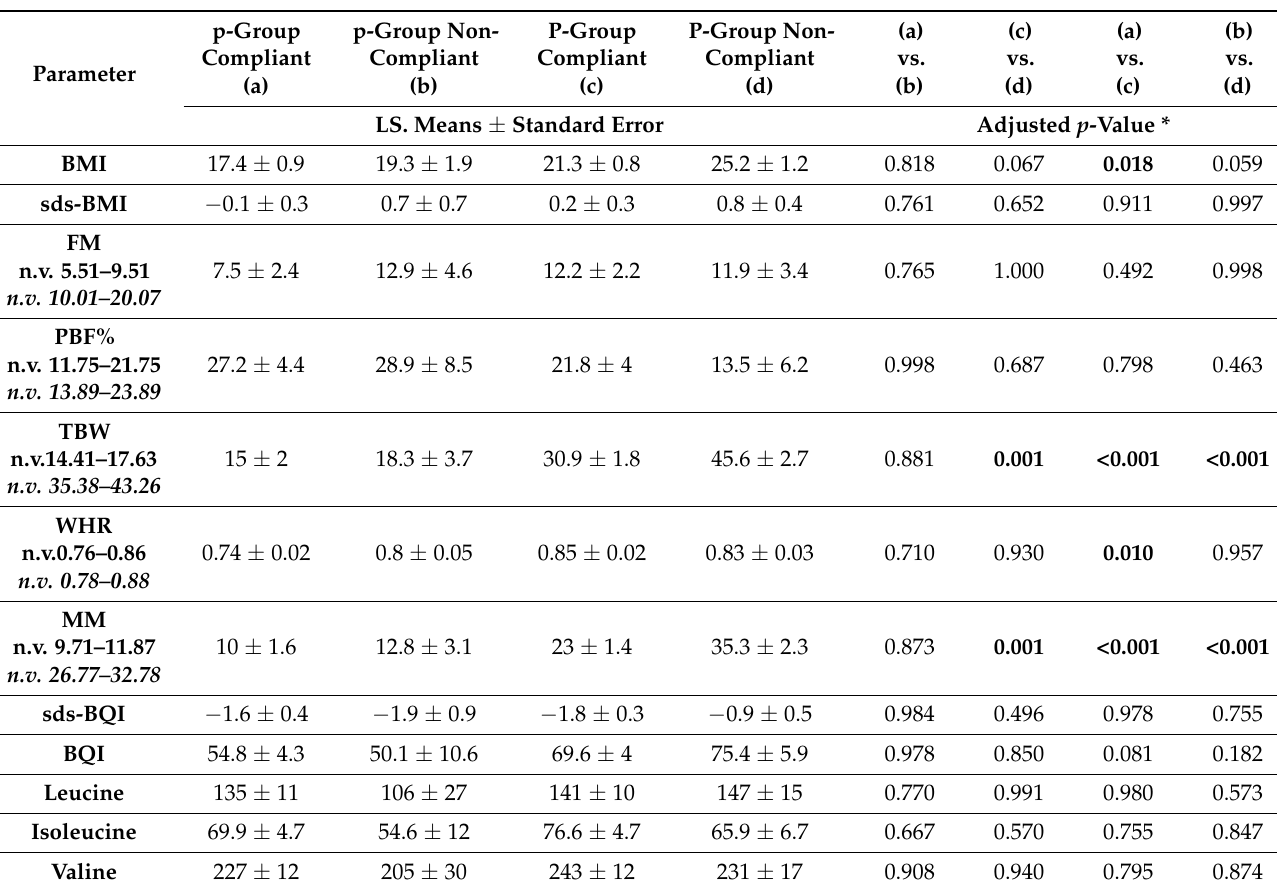
Table 2. Parameter averages estimated in the pre/post-pubertal and compliant/non-compliant groups through multivariate analysis, adjusting for